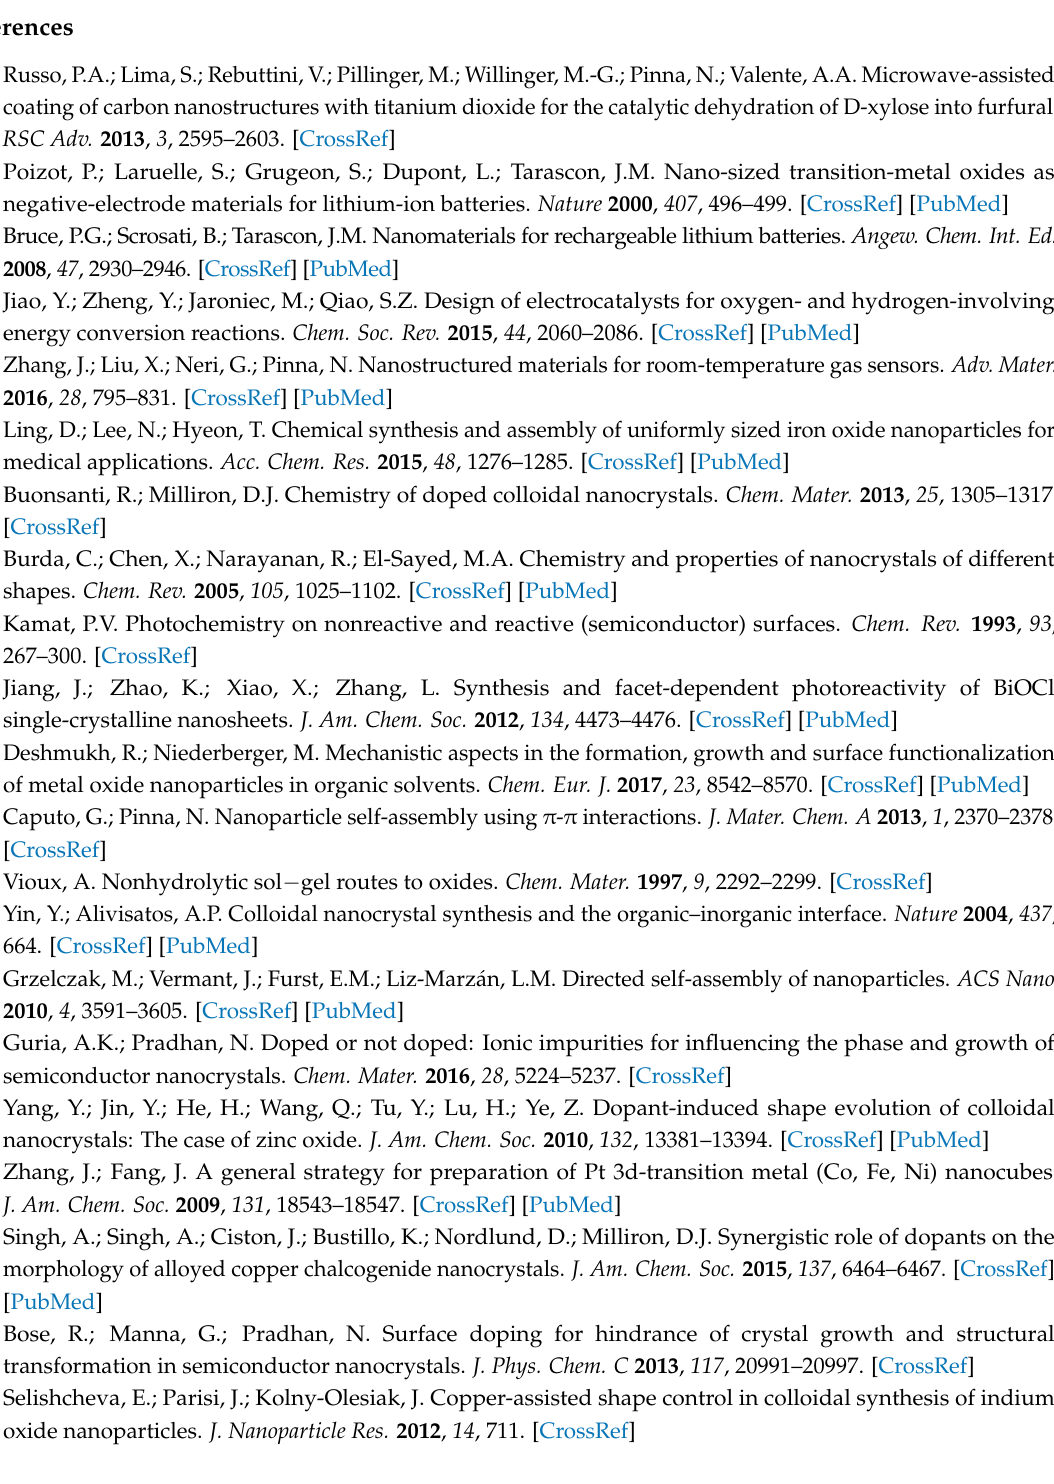
Figure S1: EDX spectra of the Co-doped ZnO materials, Figure S2: FTIR spectrum of Co 0.15 Zn 0.85